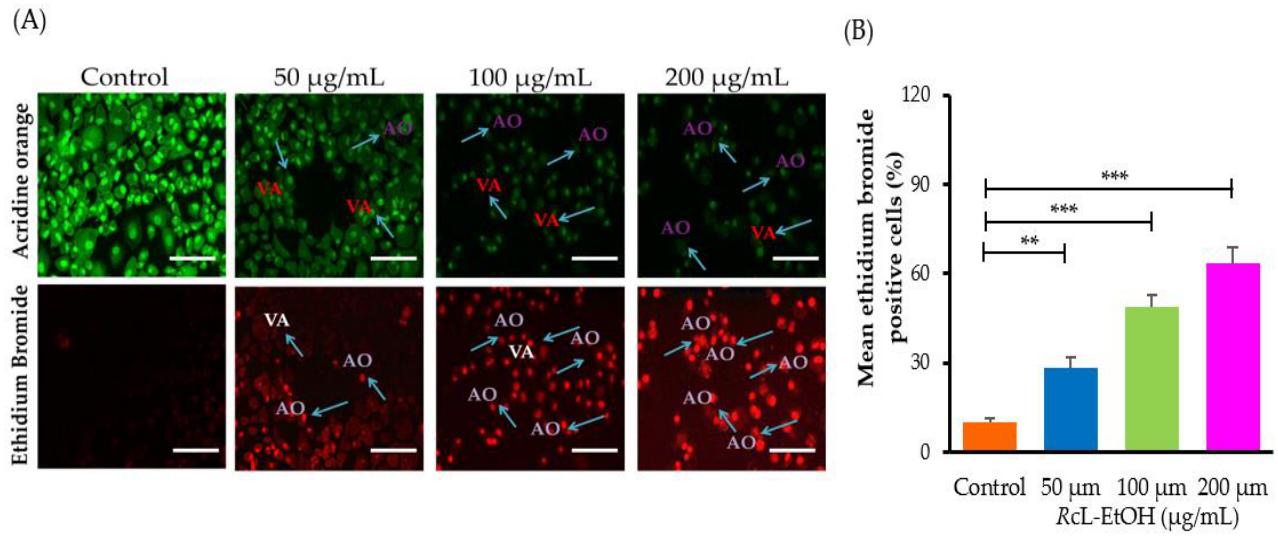
Figure 2. ( A ) Detection of RcL-EtOH-mediated cell death with acridine orange/ethidium bromide (AO/EB) double staining. Scale bar = 100 µ m. ( B ) Proportion of dead cells (EB+ cells). ** p < 0.01, (AO/EB) double staining. Scale bar = 100 µm. ( B ) Proportion of dead cells (EB+ cells). ** p < 0.01, *** *** p < 0.001 vs. p < 0.001 vs. control.